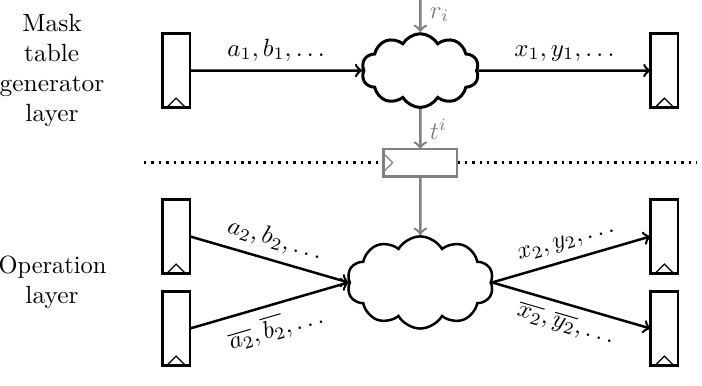
Figure 1: LMDPL gadget at a high level, components present only for nonlinear gadgets are depicted in